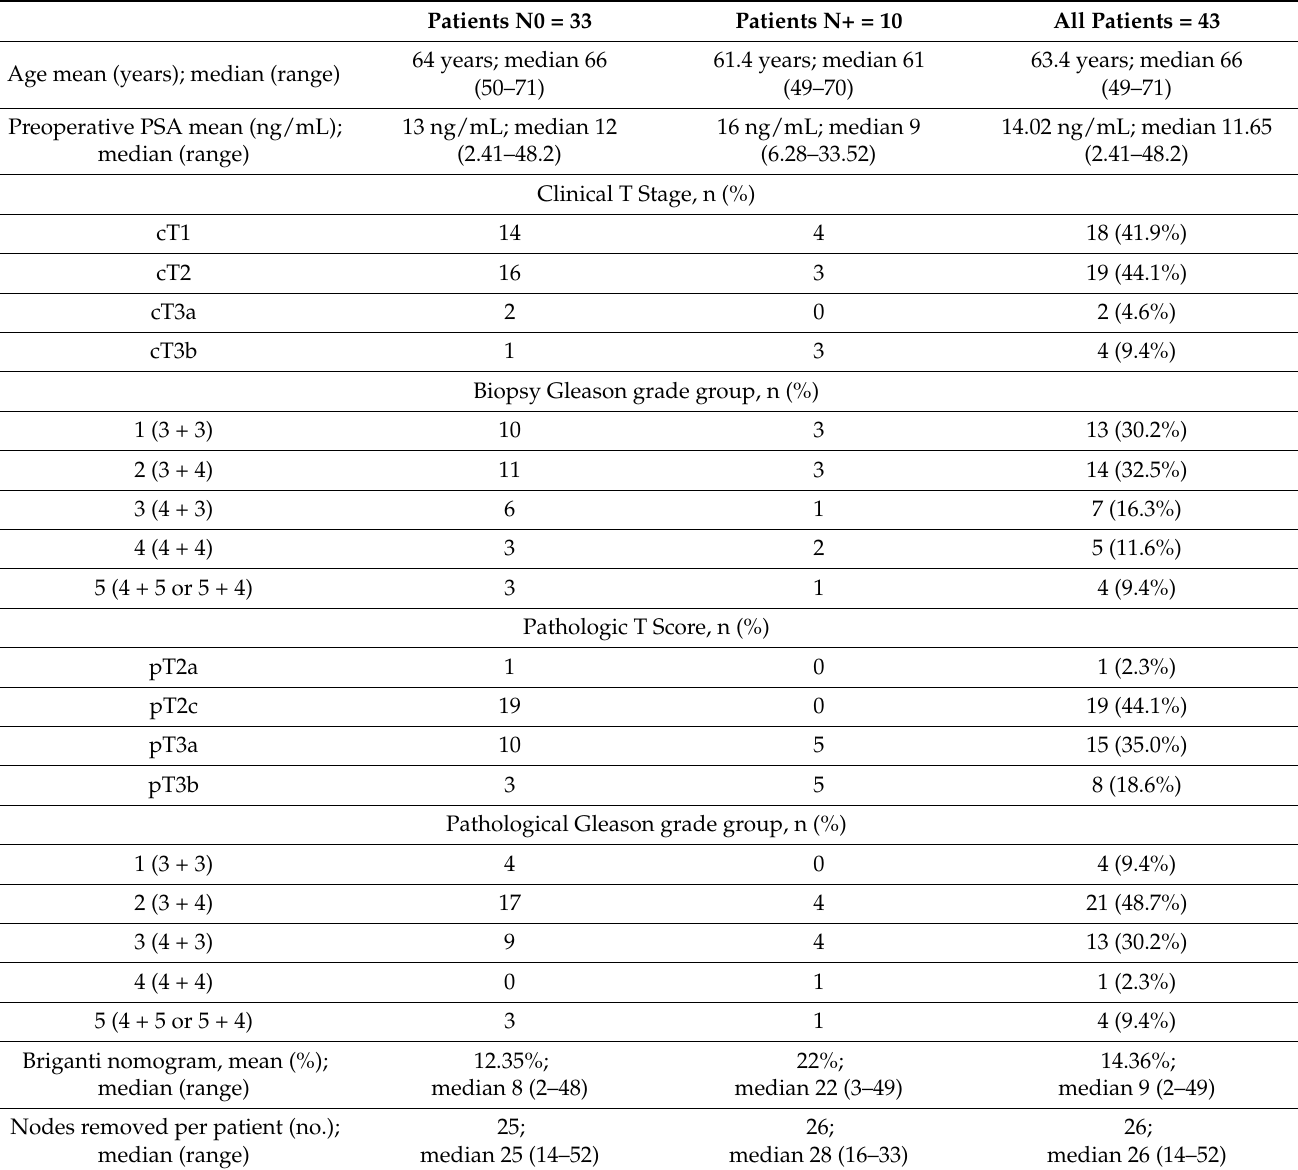
Table 1. Patient demographics and clinical characteristics. Patients N0 =